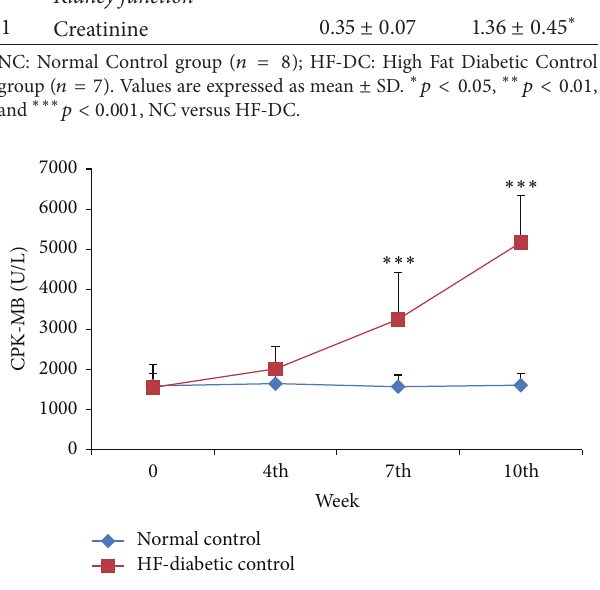
Figure 5: Time course changes in CPK-MB of NC ( 𝑛 = 8 ), HF-DC group ( 𝑛 = 7 ). Values are expressed as mean ± SD. ∗∗∗ 𝑝 < 0.001 , NC versus